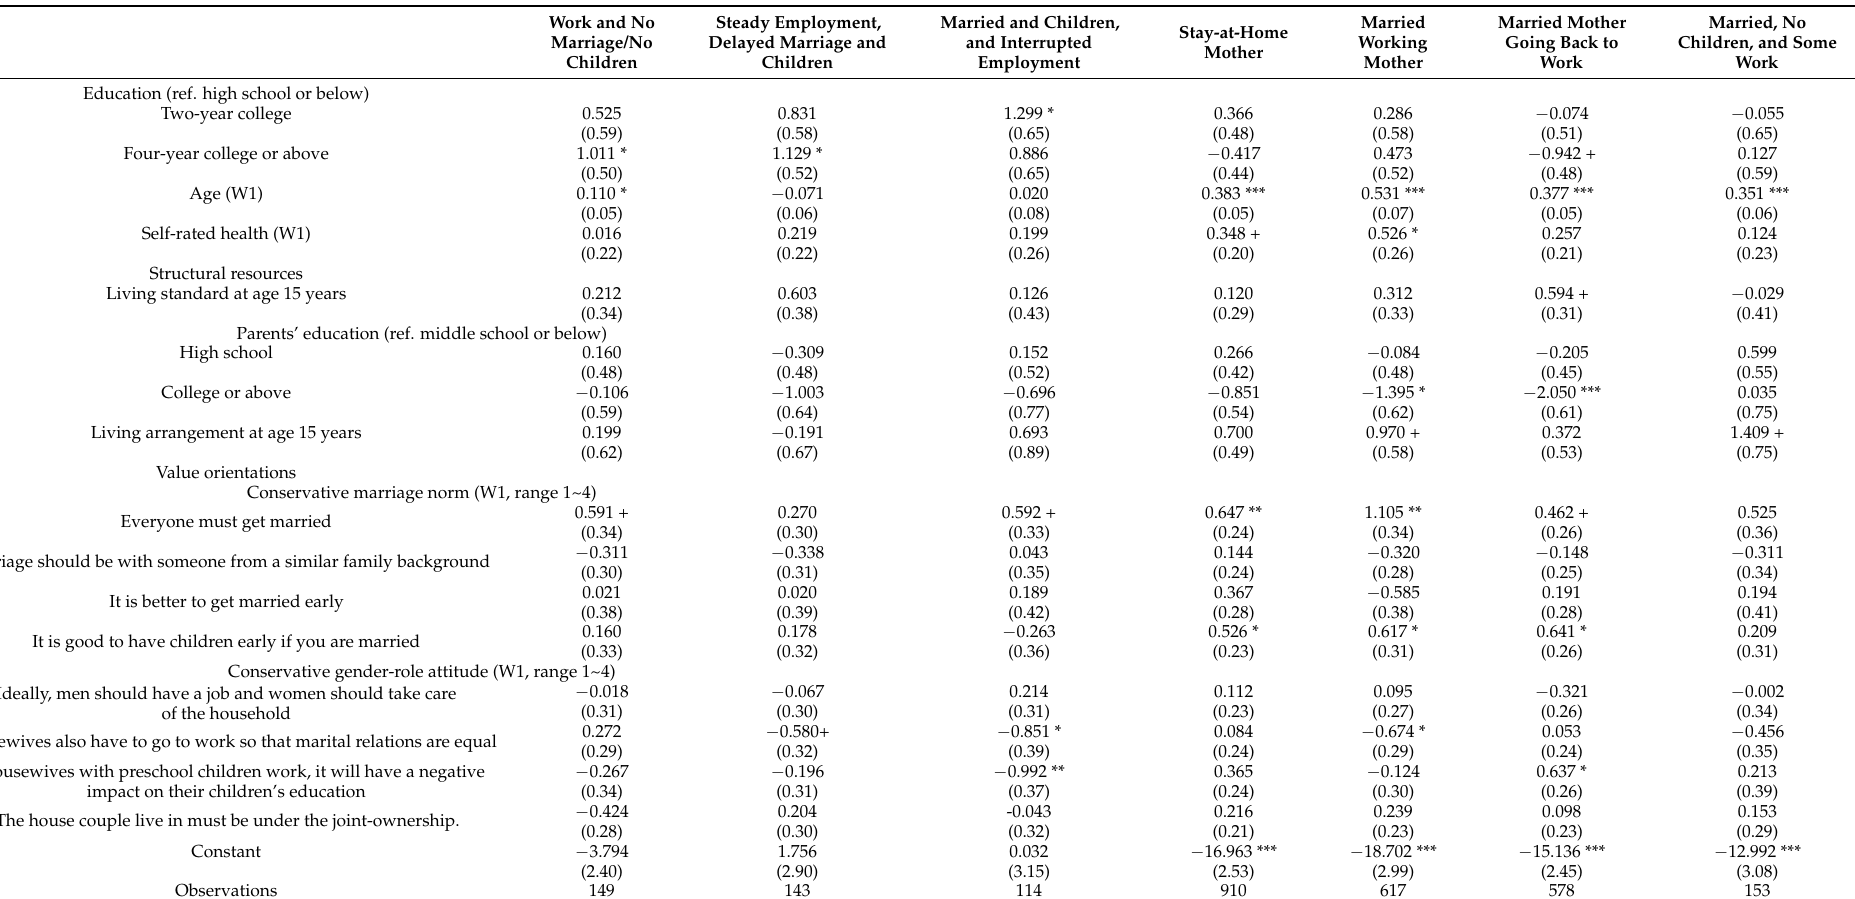
Table 2. Multinomial logistic regression of latent class membership regressed on precursor factors: B coefficient for each class compared with no family formation with limited employment.